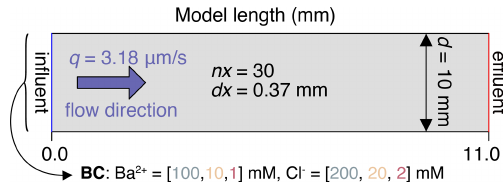
Figure 1. Numerical setup of the simulations based on the labora- tory experiment from Poonoosamy et al. (2020). Initial conditions in the column are ϕ = 0 . 46, ϕ SrSO 87 , 900m 2 / m 3 (this study), Sr 2 + = 0 . 621mM, SO 2 − Ba 2 + = 0mM, Cl − = 0mM. BC shows the boundary conditions of the flux